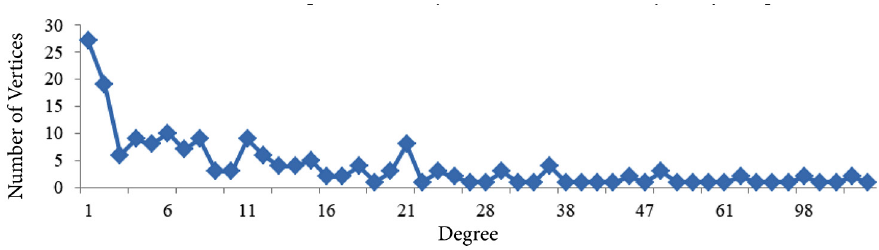
Figure 1. Degree Distribution in